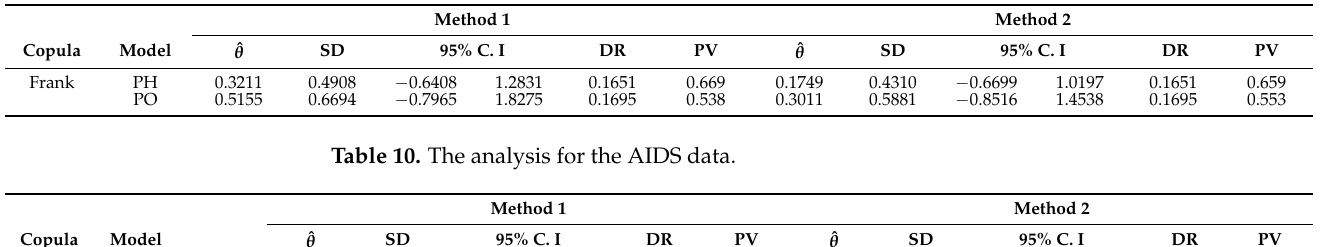
Table 10 with Method 1 and the PO model, ˆ θ = ( − 1.9358, − 2.2260, 0.2902 ) , which means